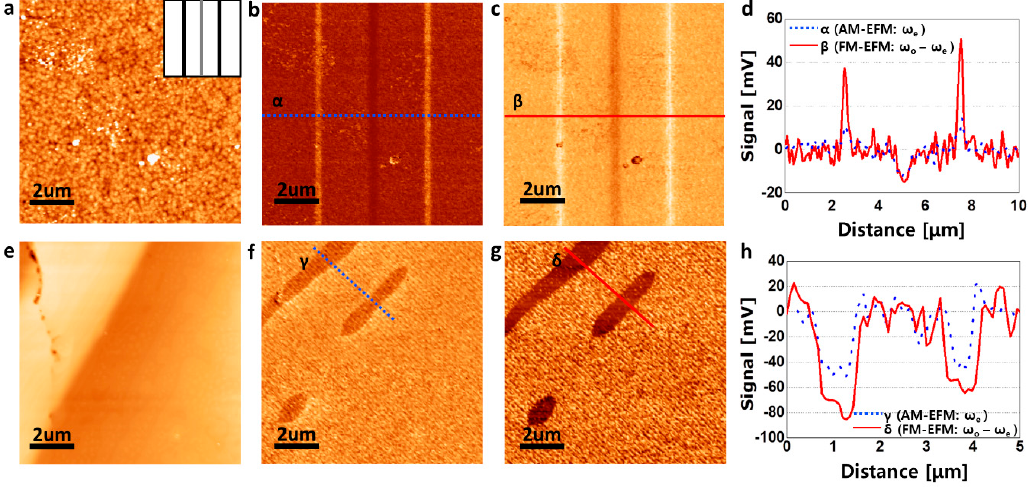
Figure 4. Applied optimal frequency to hard cantilever. EFM images of lead zirconate titanate (PZT) and triglycine surfaces (TGS) in a 10 µ m × 10 µ m scan size at a high resonance frequency ( ω o : 314 kHz). ( a ) Topographic image of PZT (inset: the external field distribution), ( b ) typical AM-EFM image of PZT ( ω e : 2 kHz), ( c ) FM–EFM image of PZT at optimized side-band frequency ( ω o − ω e : 312 kHz), ( d ) line profile of the PZT surface; ( e ) Topographic image of TGS, ( f ) typical AM-EFM image of TGS ( ω e : 2 kHz), ( g ) FM–EFM image of TGS at optimized side-band frequency ( ω o − ω e : 312 kHz) and ( h ) line profile of the TGS surface.